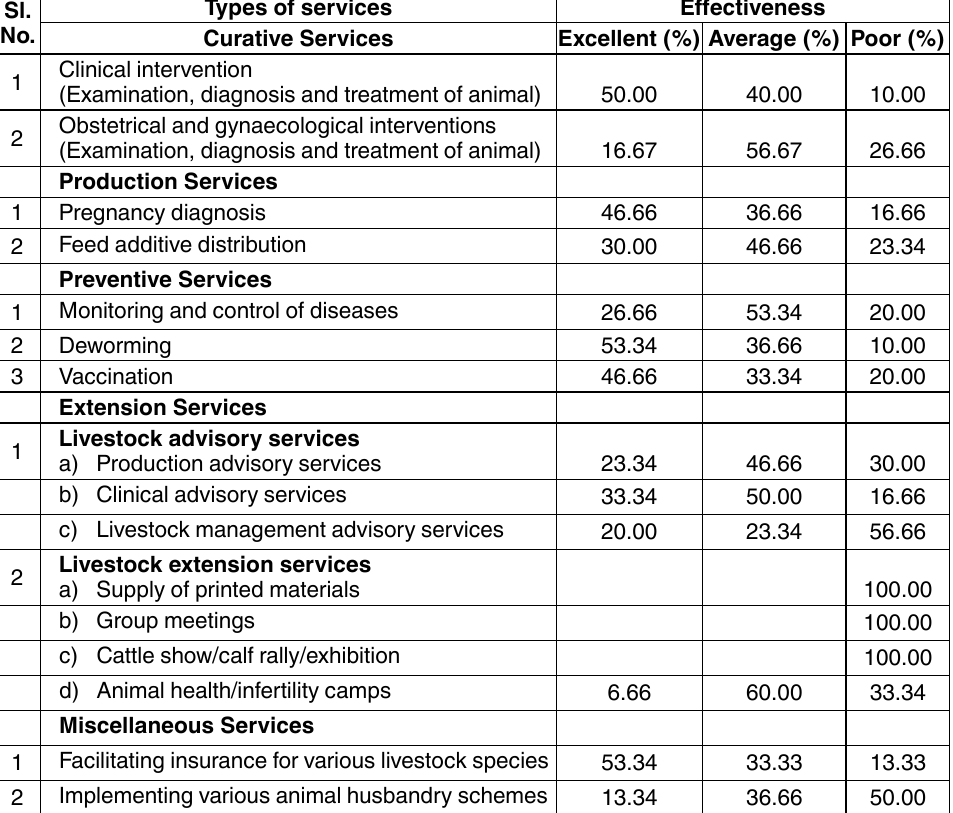
Table 2. Effectiveness of livestock services delivery as perc eived by the farmers dependent on dairy cooperative for livestock services Sl.